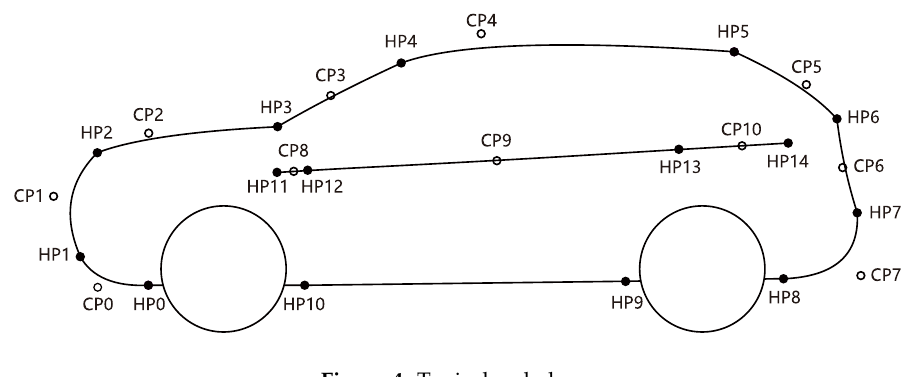
Figure 4. Typical coded case.